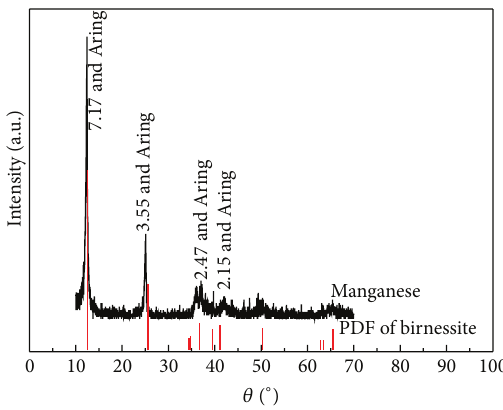
Figure 3: The XRD of synthesized